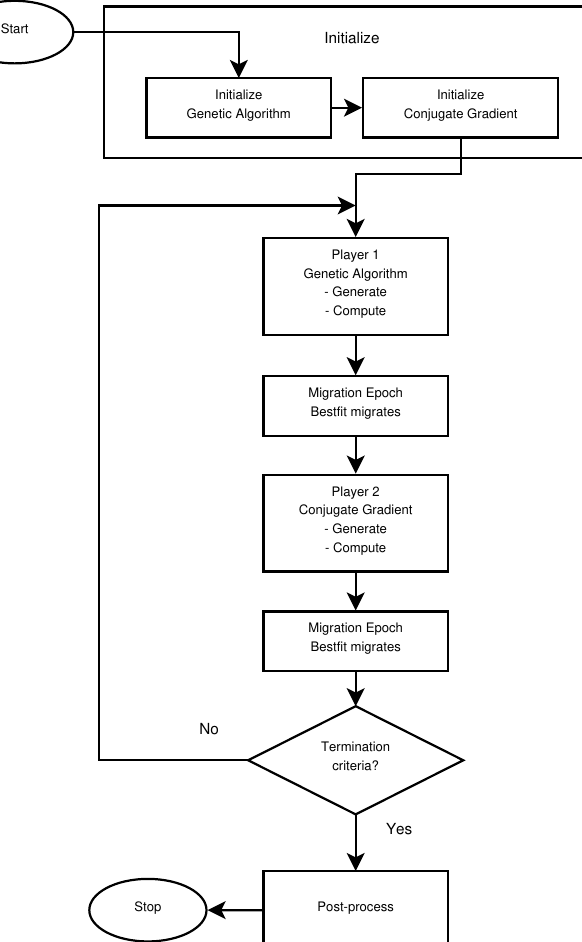
Figure 1. General algorithm of the tested Hybrid